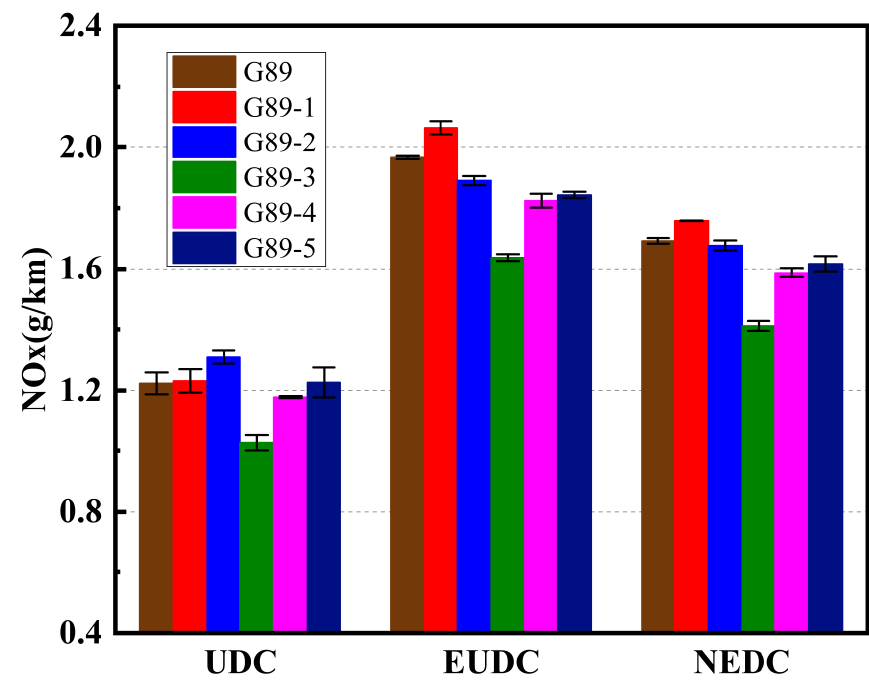
Figure 7. The NOx emissions of the PFI vehicle when fueled with the different